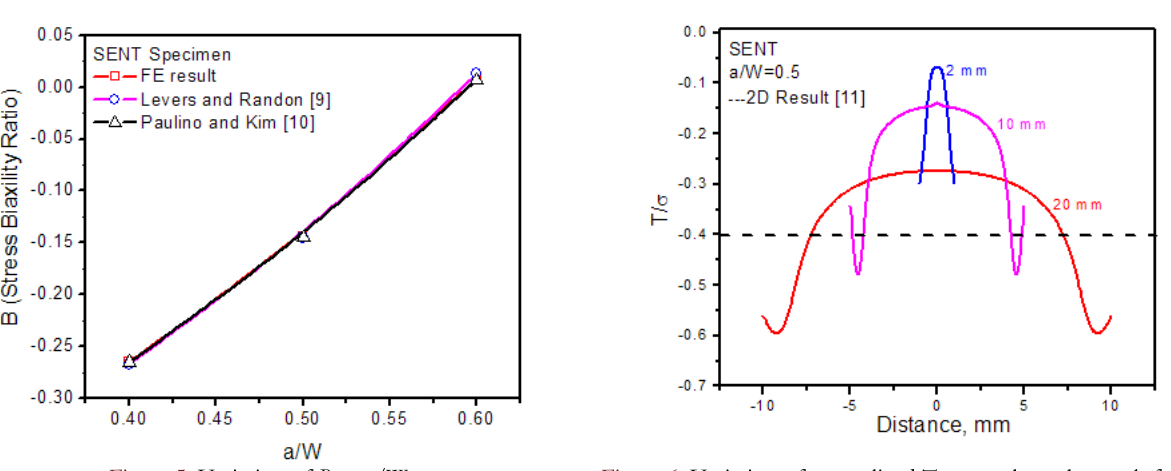
Figure 5: Variation of B vs . a/W Figure 6: Variation of normalized T-stress along the crack-front for various specimen thicknesses